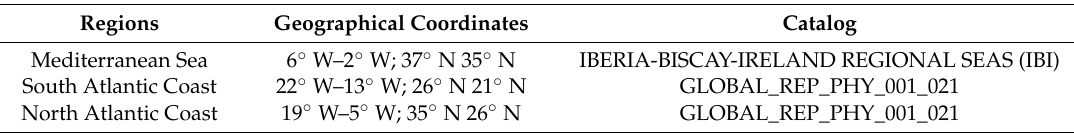
Table 1. Locations and catalog employed for the region considered.